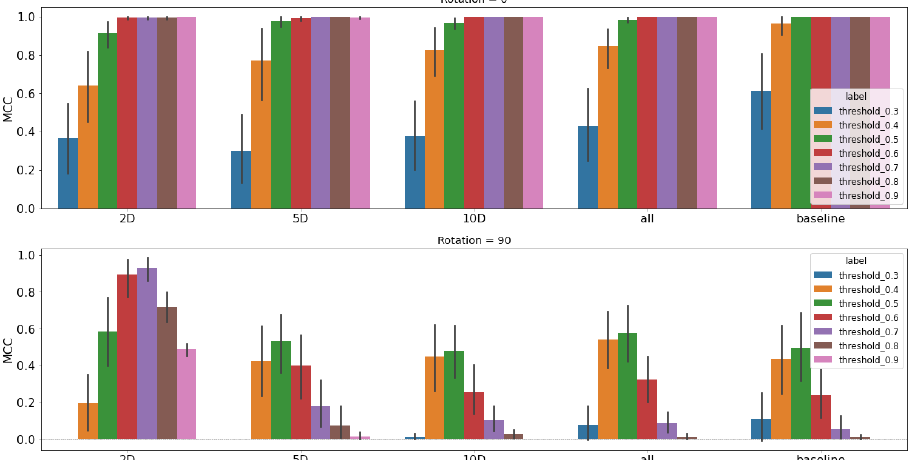
Figure 12. Performance study results for C-band using the unet classifier architecture. Each model is trained with an even split of augmented and non-augmented images, then tested on 0 ◦ rotated images ( top row ) and 90 ◦ rotated images ( bottom row ). We use the MCC metric and a sweep of thresholds to present a profile of performance rather than single metric. Training augmentations are chosen from different latent space representations; moving left to right, they are 2D, 5D, 10D, a combined selection using all three, and then finally the baseline performance is on the far right for comparison.